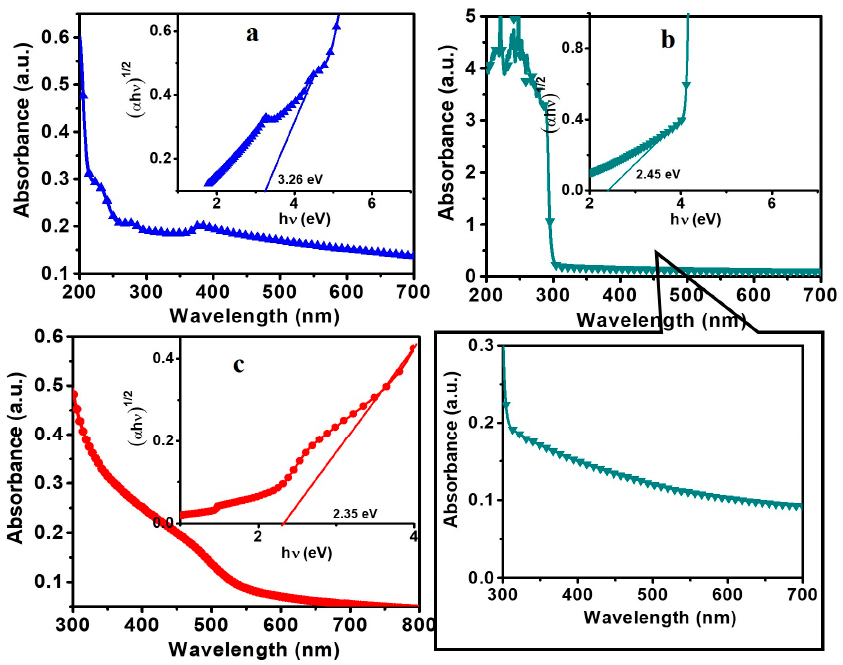
Figure 5. UV–Vis absorption spectra of the ( a ) ZnO NFs, ( b ) composite NFs, and ( c ) CdS nanoparticles (NPs); the insets show the Tauc plots.